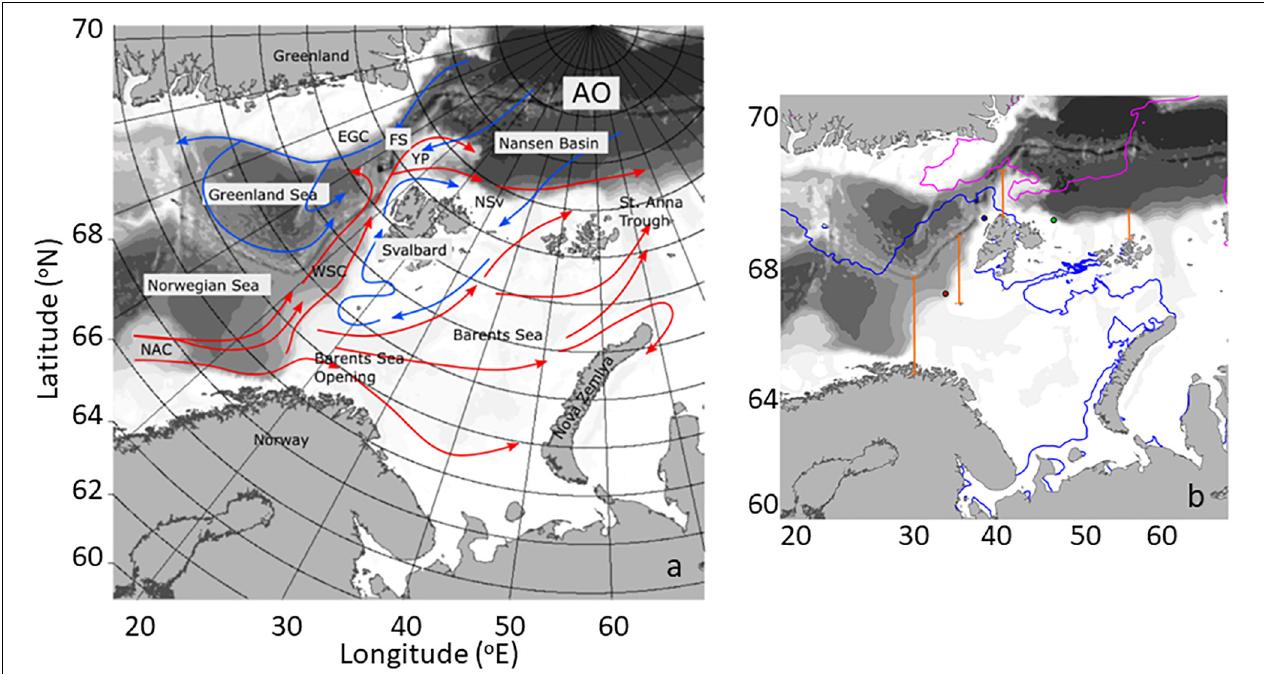
FIGURE 1 | (a) Main oceanographic features of the study area, including currents. The Atlantic water inflow (AWI) from the Norwegian Atlantic current (NAC) to the Barents sea opening (BO), the West Spitsbergen current (WSC), the area North of Svalbard (NSv), the Yermak Plateau (YP), Fram Strait (FS), the East Greenland current (EGC), and the Arctic Ocean (AO). Warm currents are depicted in red and cold currents in blue. (b) Map of the study area depicting sea ice extent in May (blue line) and September (pink line) of 2012. Four transects along the AWI (orange) depict the locations where phytoplankton carbon flux was estimated (see Table 1 ) and the dots correspond to locations where NCP (see Figure 8 ) was